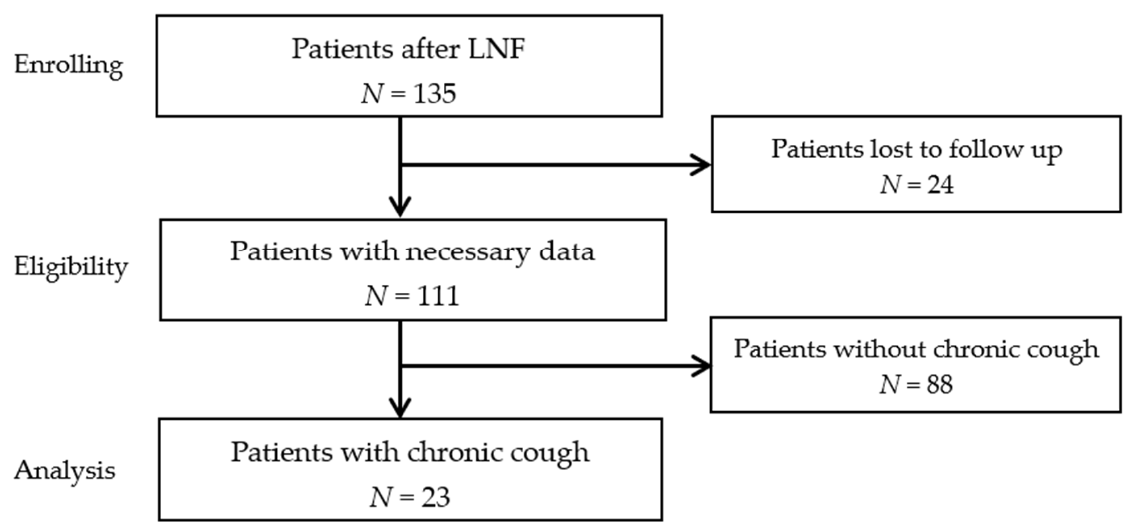
Figure 1. Flow chart of the study. LNF: laparoscopic Nissen fundoplication.